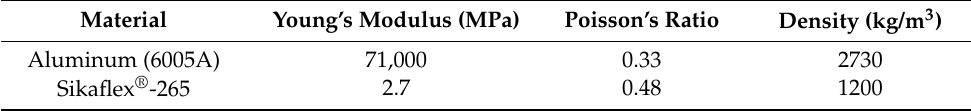
Table 1. Mechanical and physical properties of the test materials.